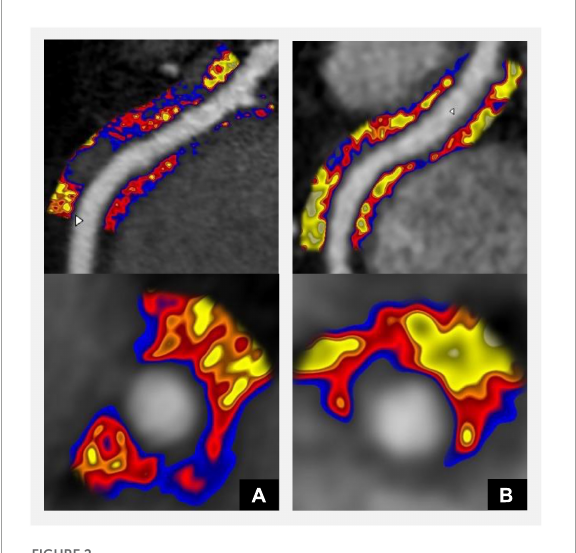
FIGURE2 CT coronary angiography derived Fat Attenuation Index (FAI) derived from the analysis of Perivascular Adipose Tissue (PVAT) surrounding coronary arteries detects inflammation and may be used to guide the management of patients with diabetes and increased cardiovascular risk. Red-blue colour indicates inflammation and correlates with high risk of future cardiovascular events; yellow colour indicates low inflammation (55). FAI score can be provided for each of the main coronary arteries and considers FAI weighted for tube voltage, anatomical factors, and basic demographics. (A) Significantly increased coronary artery inflammation (FAI score 95th centile). (B) Follow-up scan after initiation of statin treatment shows significant reduction in inflammation (FAI score 58th centile). Panels (A,B) show CPR (top panel) and axial views (bottom panel)